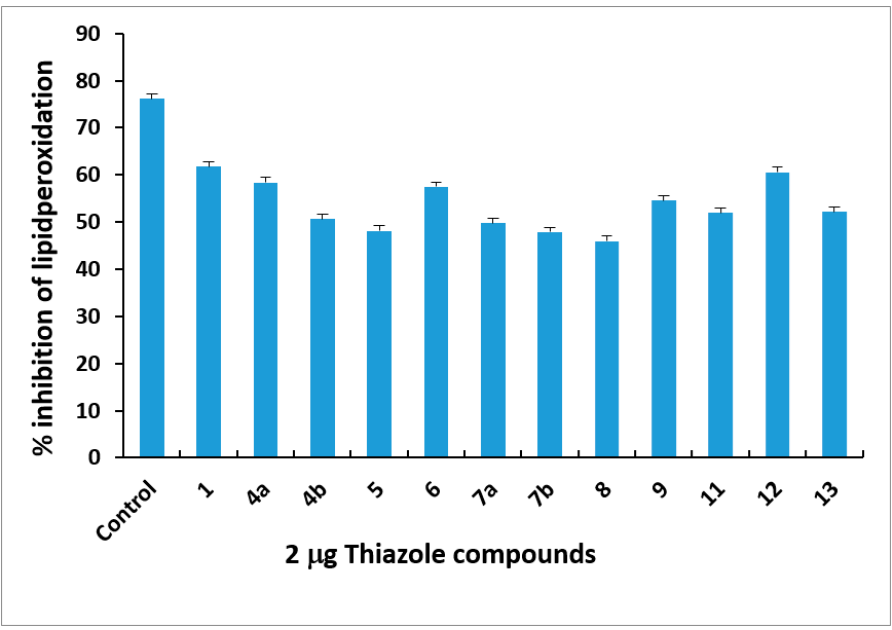
Figure 3. The activity of the tested compounds against lipid peroxidation.